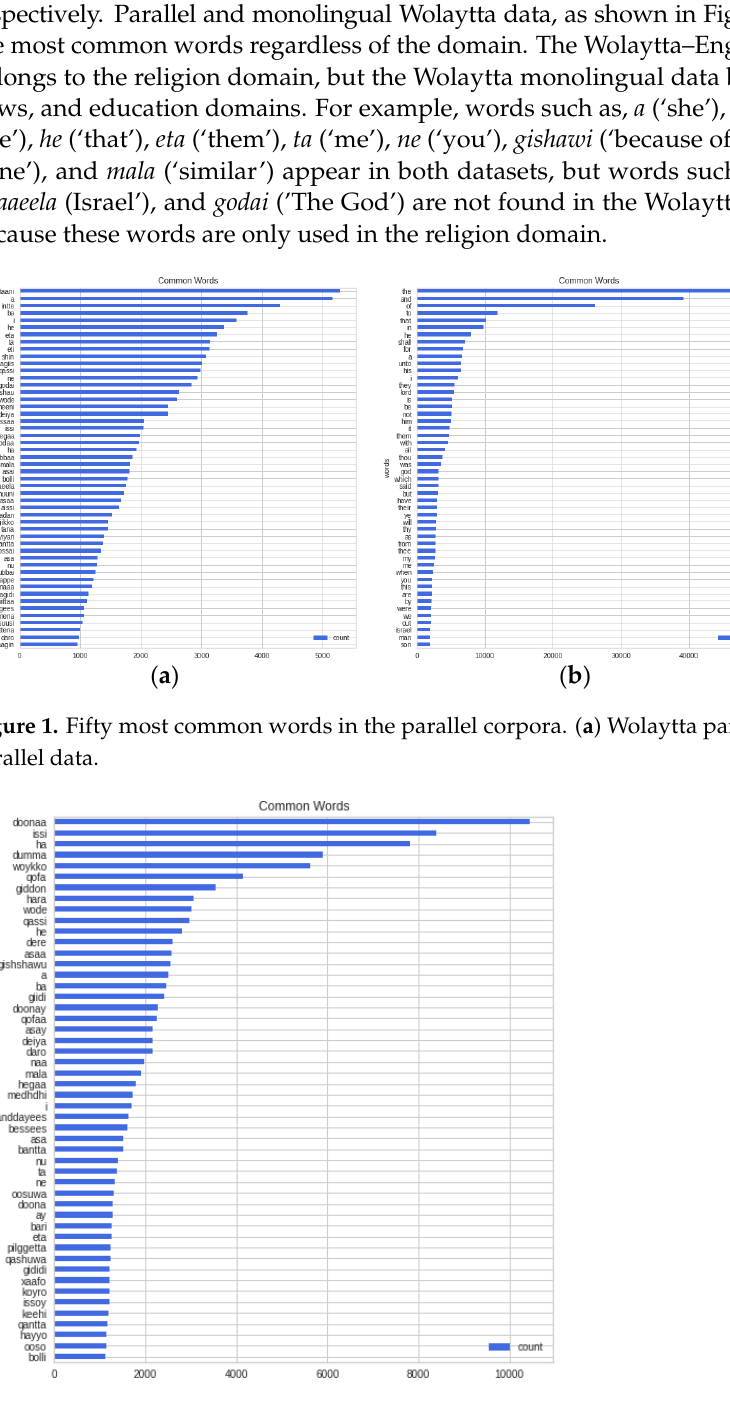
( b ) Figure 3. Sentence word count in ( a ) Wolaytta and ( b ) English parallel datasets. As can be observed in ( a , b ), the word count per sentence in Wolaytta and English is within the range [2–40].